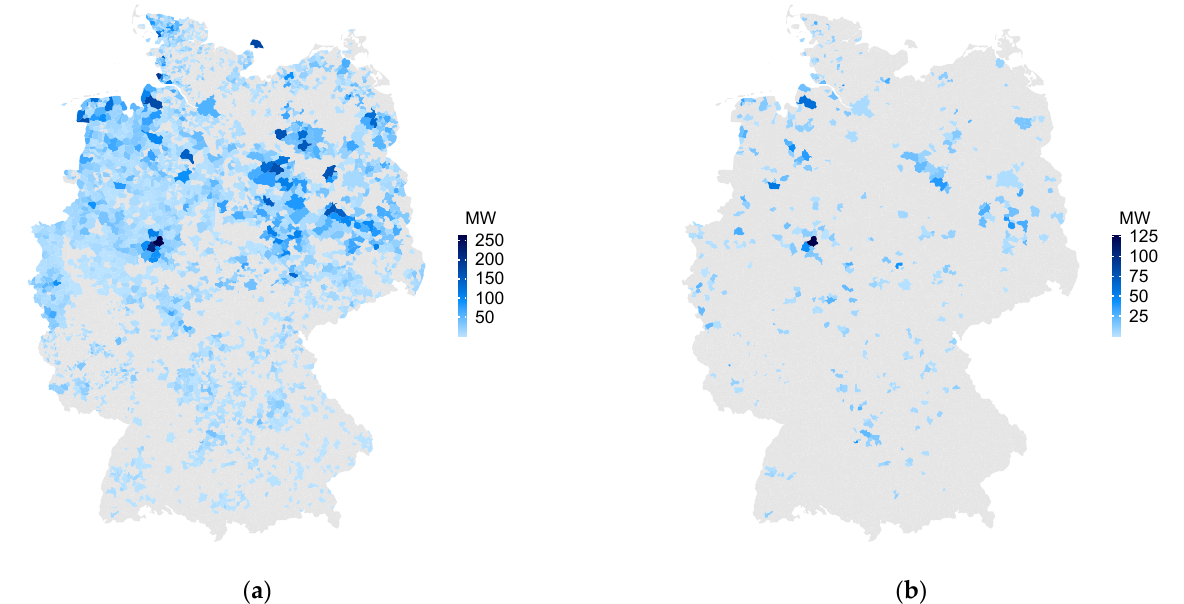
Figure 1. ( a ) Installed wind turbine capacity and ( b ) intra-annual capacity increase at LAU2 level in Germany for 2016. In the grey areas no wind turbines are ( a ) installed or ( b ) have been added during this